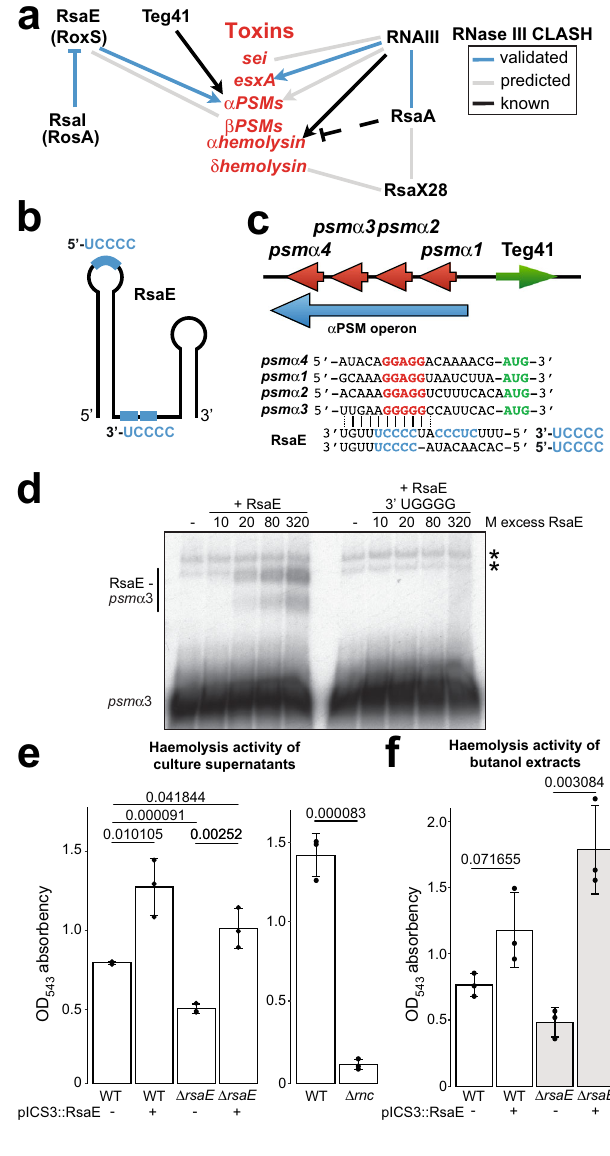
Fig. 6 CLASH predicts toxin production is extensively regulated by sRNAs. a Predicted interactions between sRNAs and sRNAs, and sRNAs with mRNAs encoding for toxins (indicated in red). Black line indicates interactions experimentally veri fi ed by previous groups. Grey lines indicate interactions predicted by CLASH and blue lines indicate interactions predicted by CLASH that we experimentally veri fi ed. Dashed lines indicate indirect regulation. b Schematic representation of the structure of the RsaE sRNA. Blue lines and blue text indicate the RsaE UCCCC seed sequences. c Schematic representation of the α PSM operon (blue arrow), the location of the four α PSM genes in the operon (red arrow) and the location of the Teg41 sRNA in this genomic location. Below that, a multiple sequence alignment of psm α 1-4 Shine-Dalgarno (red) and translational start codon (green) regions aligned to the RsaE seed sequence motifs. CLASH detected interactions between the 3 ʹ UCCCC motif (light blue) of RsaE with the psm α 2 and psm α 3 transcripts but similar base-pairing interactions can also be drawn with all the PSM transcripts and with the 5 ʹ UCCCC motif (light blue). d The 3 ʹ UCCCC motif of RsaE is involved in base-pairing with psm α 3 . EMSA between radiolabelled RsaE and psm α 3 transcript containing the binding sites predicted by CLASH. As a negative control, an RsaE fragment was used in which the 3 ʹ UCCCC motif was mutated to UGGGG. Asterisks (*) indicate self-oligomerisation of the psm α 3 RNA as these are produced in the absence of RsaE and do not increase in abundance when increasing amounts of RsaE is added. Results from a single experiment is shown and the raw data is provided in the Source Data fi le. e Haemolytic activity of supernatants from USA300 LAC WT, RsaE overexpressing strains, Δ rsaE and Δ rnc (RNase III) deletion mutants. Supernatant from overnight cultures was mixed with human blood and the degree of blood cell lysis was measured through optical absorbency. Shown are the averages and standard deviations calculated from three independent experiments. Values above bars display respective p value, obtained using Student ’ s two-tailed, unpaired t test. f As in e but after performing butanol extraction